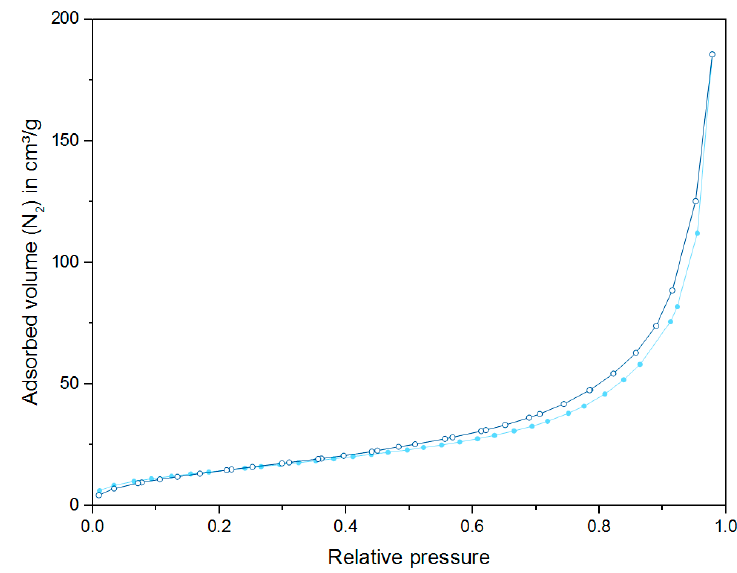
Figure 4. Nitrogen adsorption (light blue, solid circles) and desorption (dark blue, open circles) isotherm of T.p. enriched with aluminum.